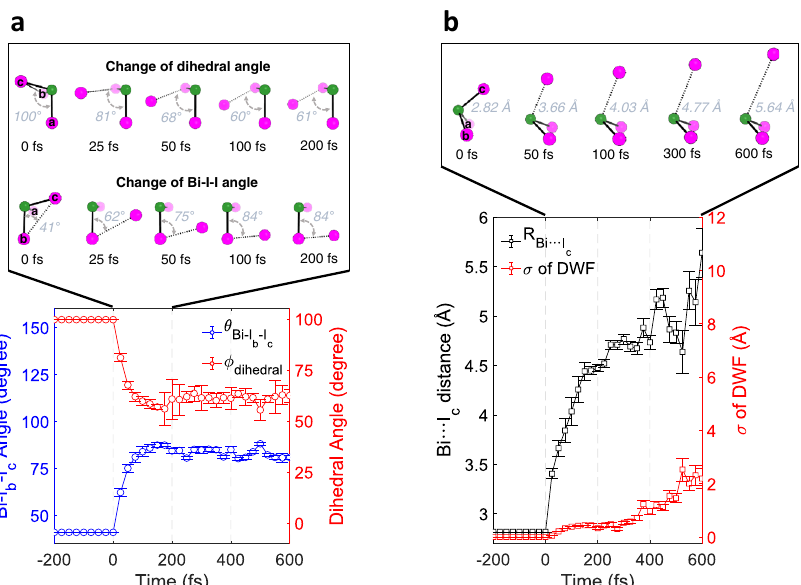
Fig. 5 Structural parameters selected to represent the structural motion of the initial isomerization, dissociation of BiI 3 , and coherent wavepacket. a The mean Bi-I b -I c angle and I a -Bi-I b -I c dihedral angle of the early isomer are shown in blue and red dots, respectively, with the corresponding standard deviations as error bars. b The mean Bi···I c distance of BiI 3 undergoing dissociation and the root-mean-squared displacement ( σ ) obtained from the Debye- Waller factor (DWF) are shown in black and red squares, respectively, with the corresponding standard deviations as error bars. The insets in both a and b, show the snapshots of the molecular structure at some representative time delays. Green and purple spheres stand for Bi and I atoms, respectively, and three I atoms are labeled with a, b, and c. The structural parameters shown in ( a ) and ( b ) were obtained from the structural fi t analysis on Δ S iso ( q , t ). The error bars in ( a ) and ( b ) at time delays earlier than 175 fs are one-standard-deviation error values calculated from the covariance matrix of the coef fi cients of quartic polynomials used to model the parameters during the structural fi t analysis. The error bars of structural parameters in a and b at time delays later than 175 fs are the averaged one-standard-deviation error values obtained from the fi ts starting from ~5000 random structures for each time delay. The error bars for the σ of the DWF at time delays later than 175 fs are the one-standard-deviation error values obtained from the fi t performed at each time